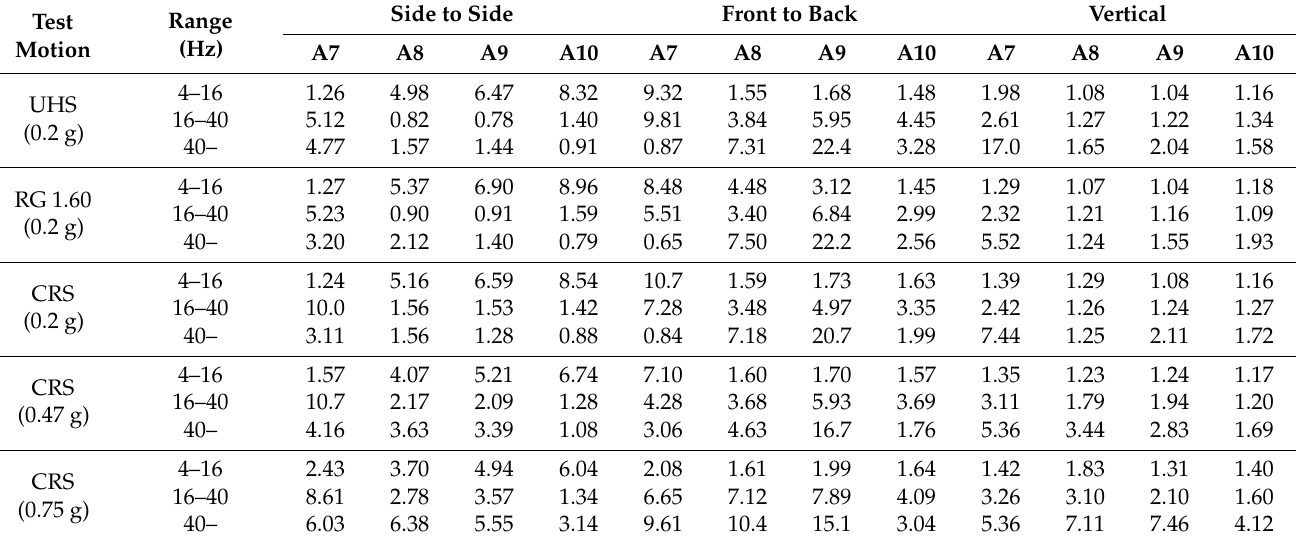
Table 6. Amplification results of in-cabinet response based on input